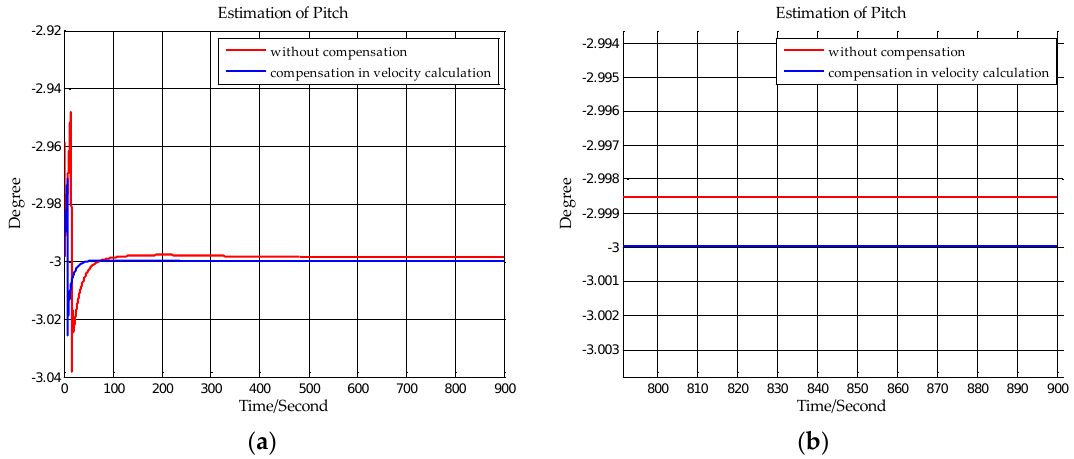
Figure 7. ( a ) is the estimation of roll with compensation in velocity calculation, and ( b ) is the enlarged view of ( a ) in the last 100 s.